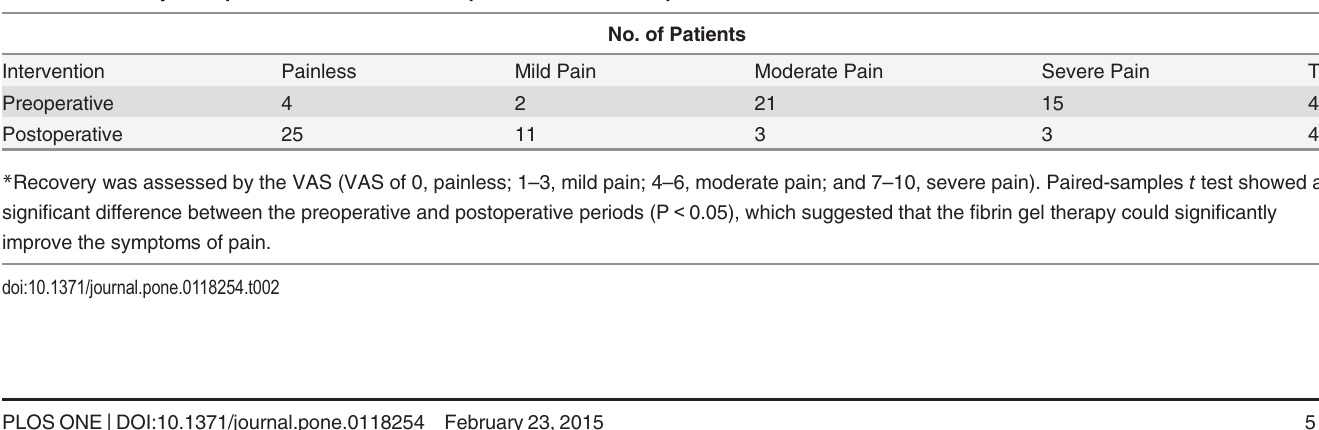
Table 2. Recovery from pain after a mean follow-up of 24 months in 42 patients *